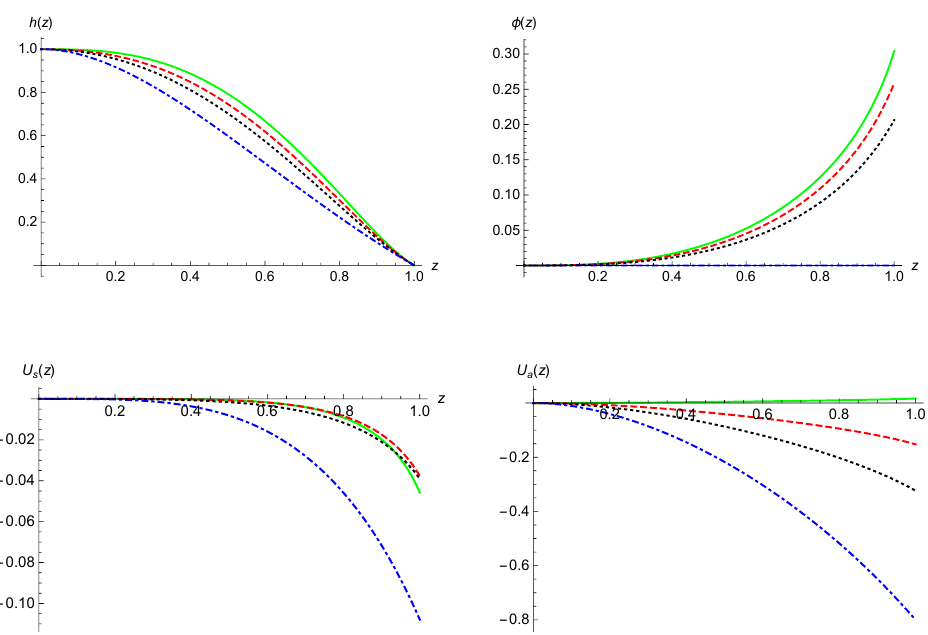
Figure 1 . Plots of the functions in the metric and dilaton (cid:12)elds in terms of coordinate z , for (cid:12)xed p 1 = 1, k 1 = 0 : 1, (cid:20) = 1, with k 2 = 0 (Green), 1 (Red-dashed), 2 (Black-dotted), and 4 : 8294